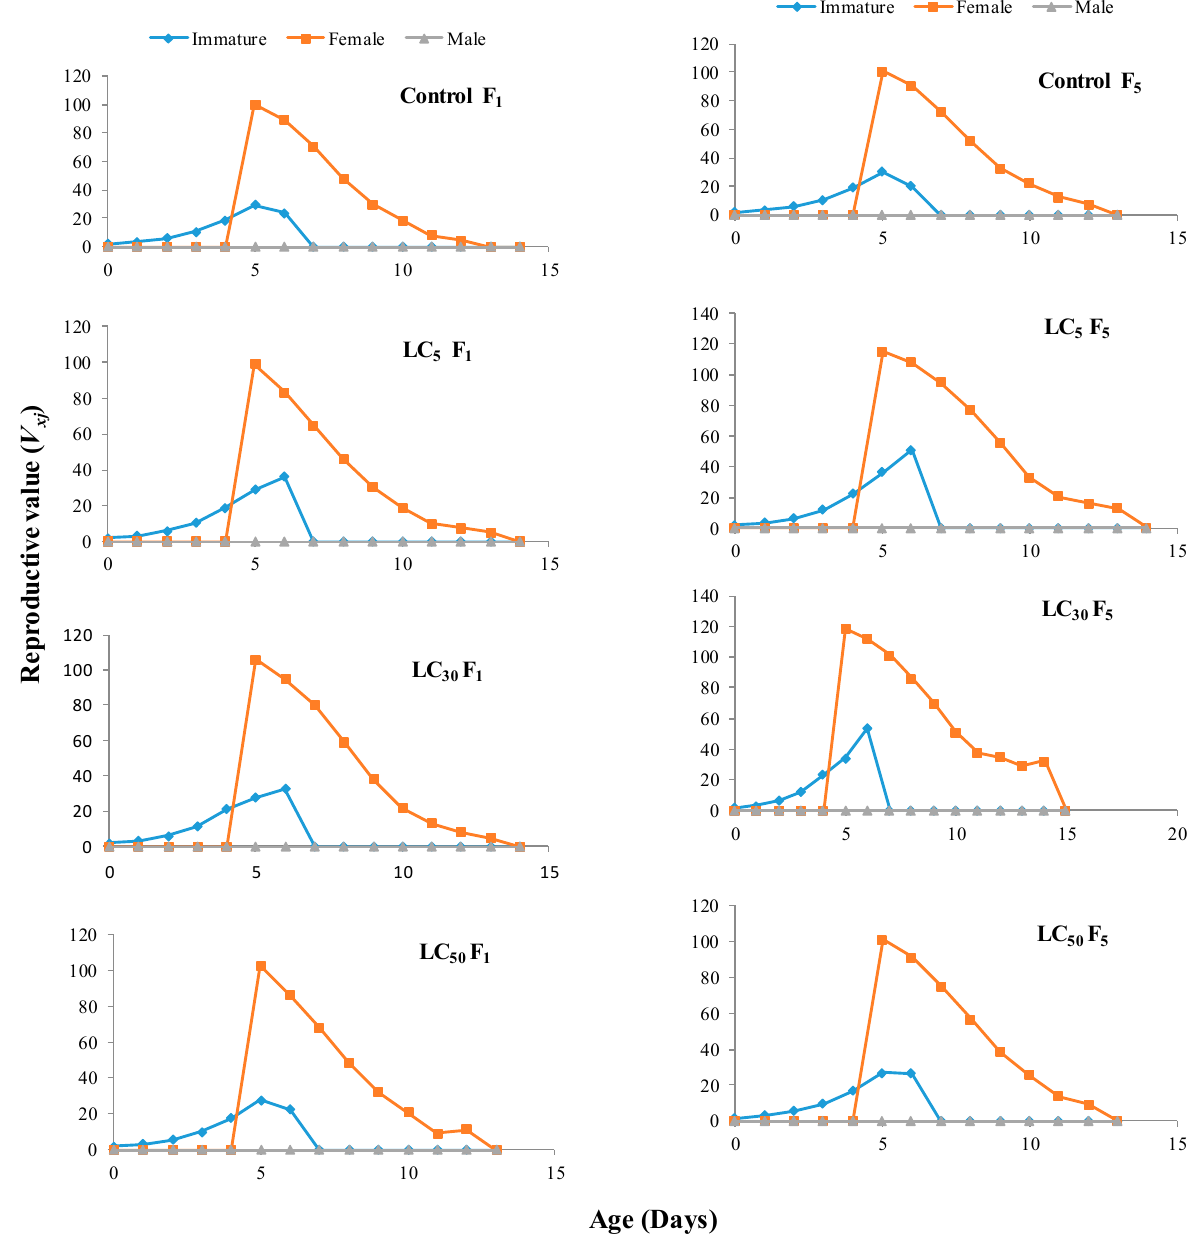
Figure 4. Age–stage–reproductive value ( v xj ) of T . chilonis adults treated with acetone and LC 5 , LC 30 , and LC 50 concentrations of imidacloprid in F 1 and F 5 generations.